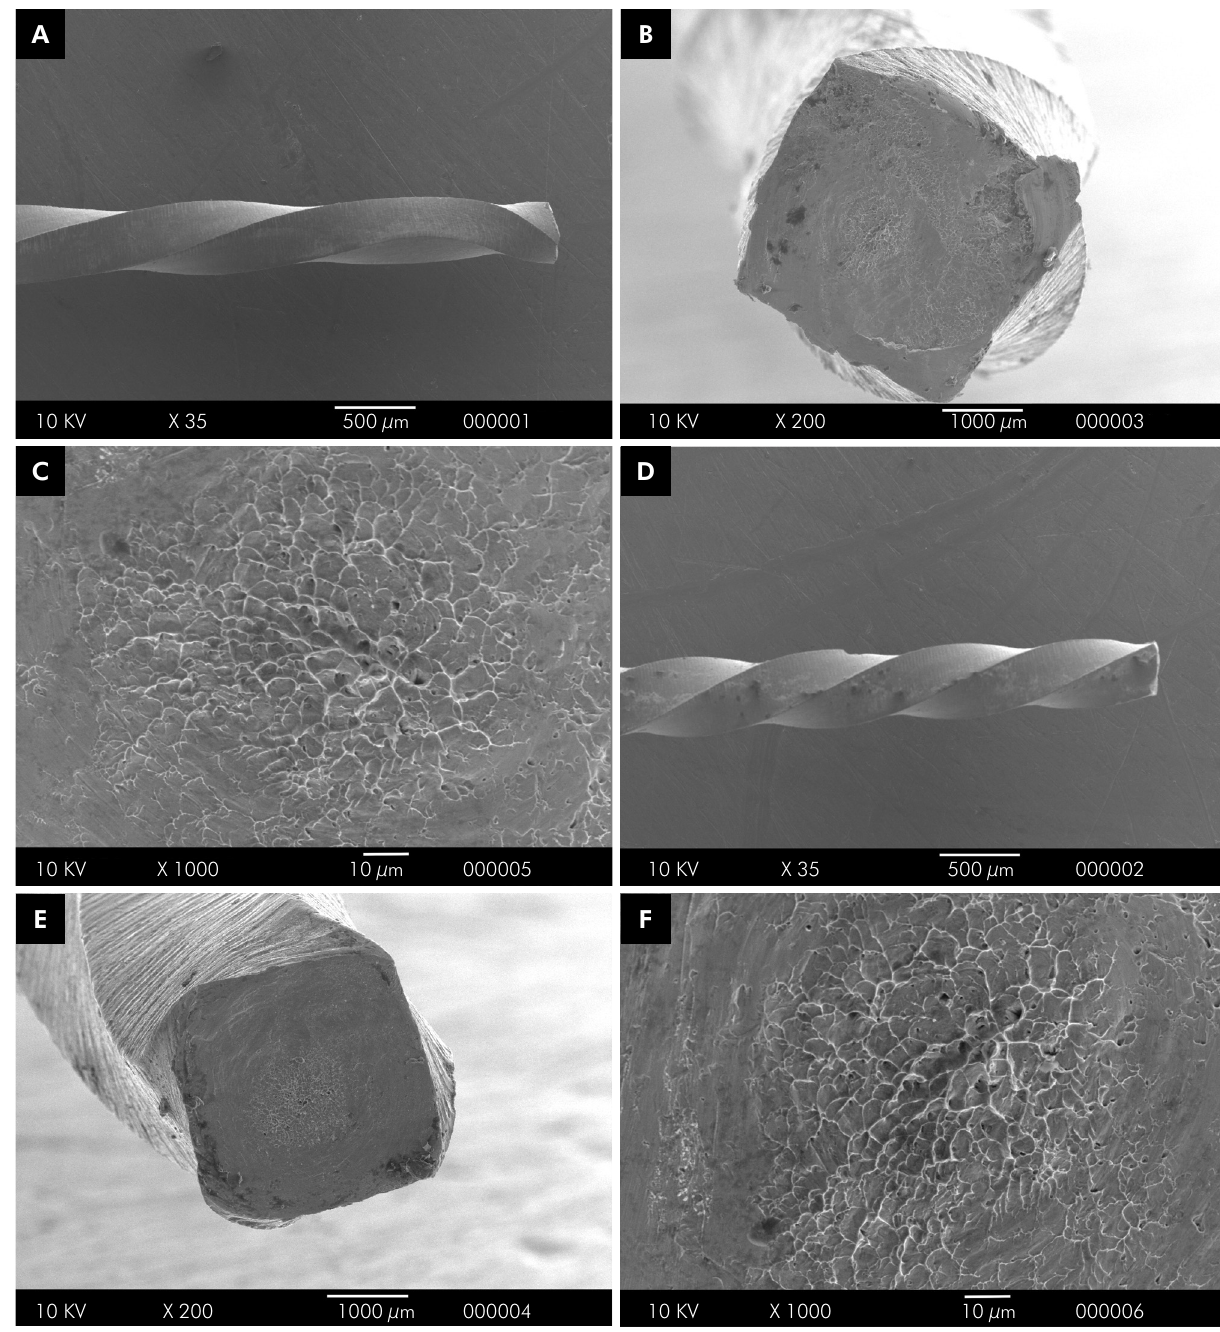
Figure 1. SEM images of fractured reciprocating (A, B, and C) and rotary (D, E, and F) pathfinding instruments during glide path preparation. Images A and D show a lateral view of the spiral flutes of the instruments at 35X magnification; B and E show the front view of the fragments with the circular box indicating the concentric abrasion mark at 200X magnification; C and F show the concentric abrasion mark at 1000X magnification; the skewed dimples near the center of rotation are features typical of torsional